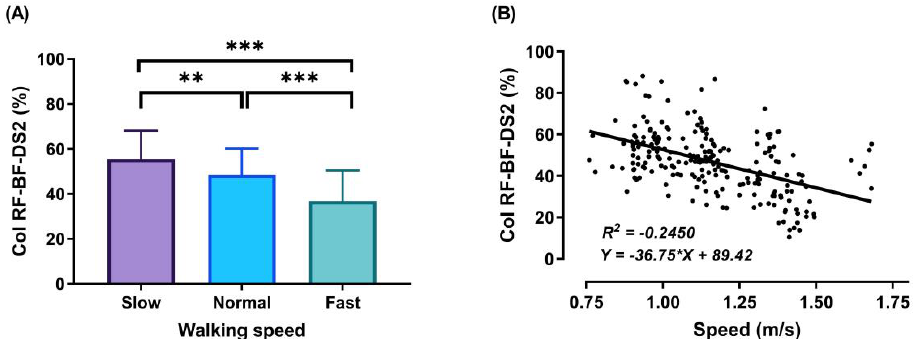
Figure 8. Mean of thigh muscles (RF-BF) co-activation at different walking speeds (slow, normal, and fast) during walking phases: DS2 ( A ). ANOVA results showing the effects of changing in CoI of thigh muscles during walking speed (slow, normal, and fast). Correlation between walking speed and thigh muscles (RF-BF) co-activation during DS2 walking phase ( B ). Asterisk signs above the line represent significant differences between walking speed: (***) indicates p ˂ 0.001, and (**) indicates p ˂ 0.01.